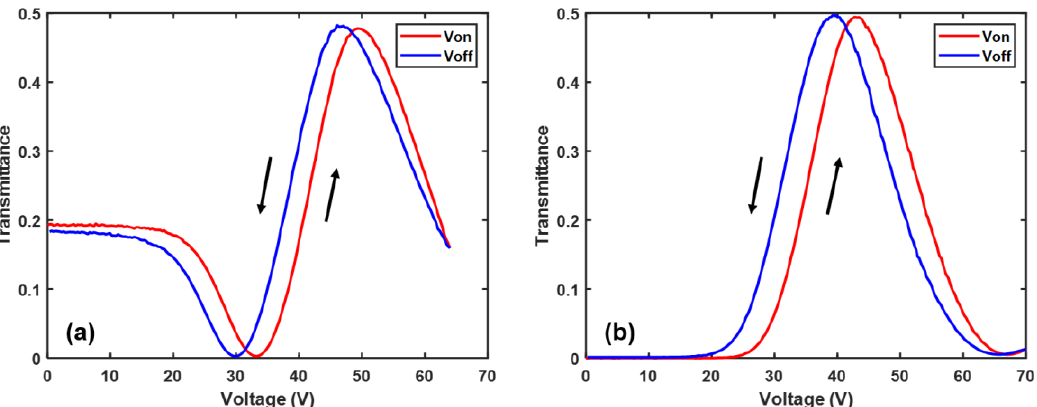
Figure 6. Forward and backward scans of voltage-dependent transmittance (VT) curves of ( a ) PNLC-